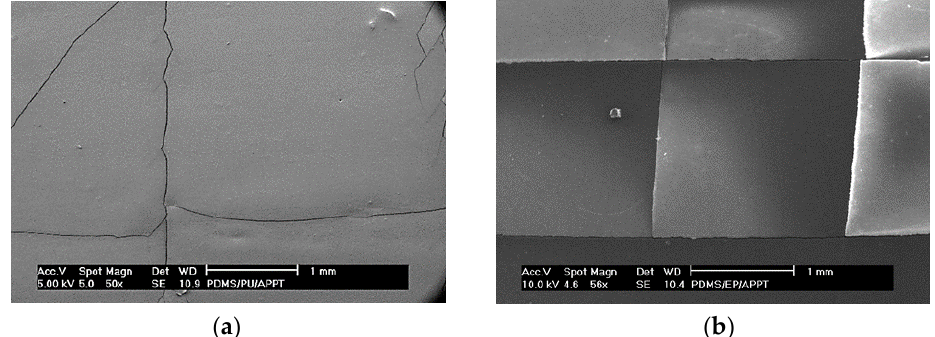
EP, ( c ) with APPT painted with PU, and ( d ) with APPT painted with EP.